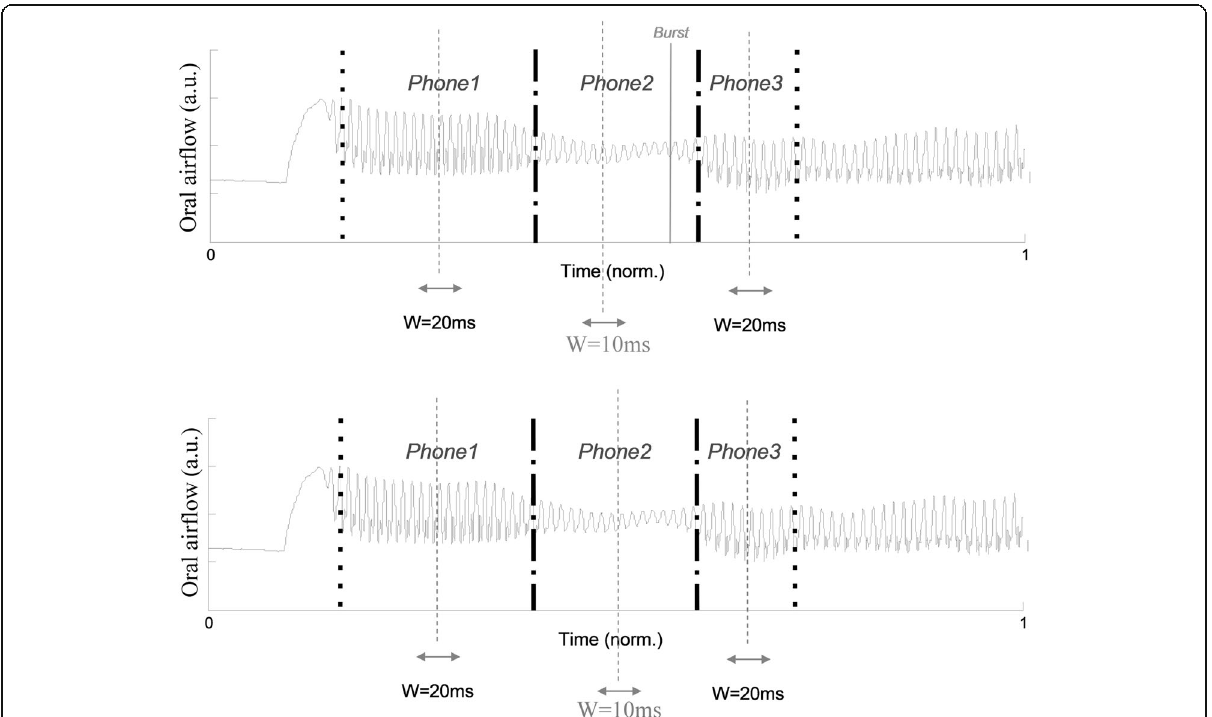
Fig. 1 Oral airflow signal. The vertical dotted lines represent the start of phone1 and the end of phone3, i.e. the speech units surrounding the target phone (which was always a stop). The vertical dash-dotted lines represent the start and end of phone2, the stop. The bidirectional arrows represent the location of the analysis windows. The strategy used to assign the vertical dashed line is illustrated for the tokens with a discernible burst (top) and without a discernible burst (bottom): w hen the burst was not discernible , this annotation corresponded to the middle of the stop. The x and y-axes were